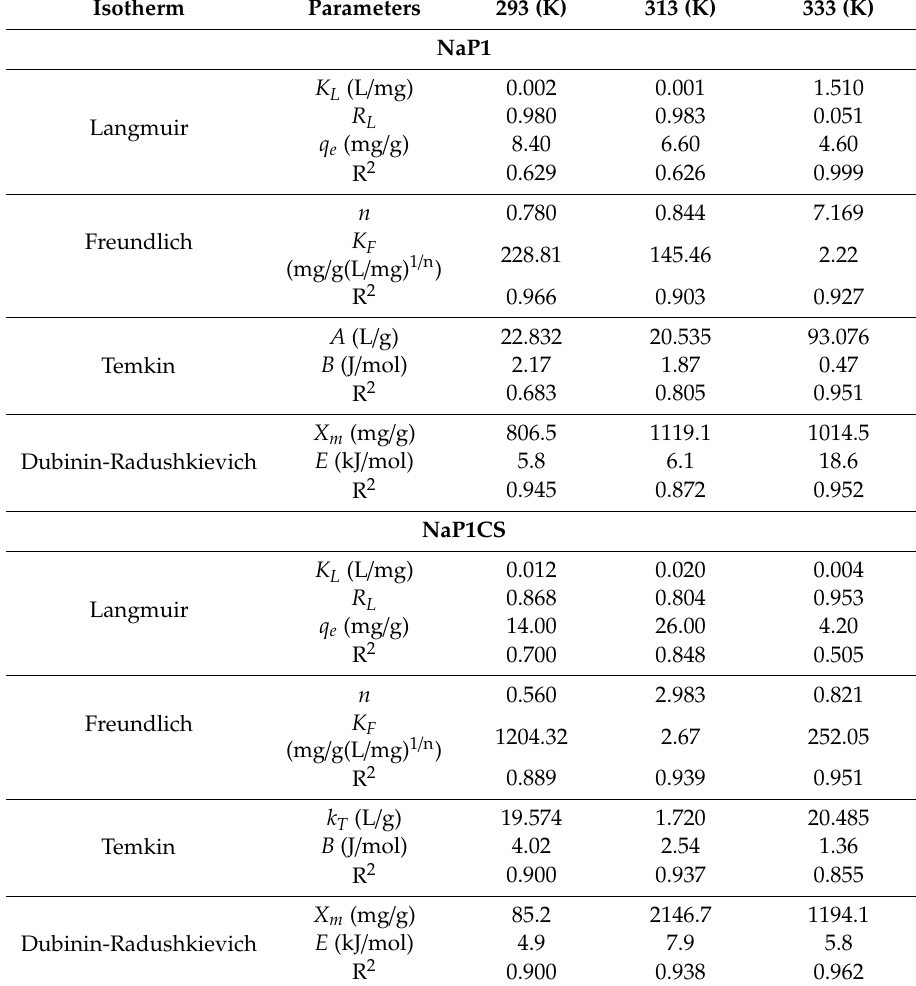
Table 4. Comparison of estimated parameters obtained from the Langmuir, Freundlich, Temkin,